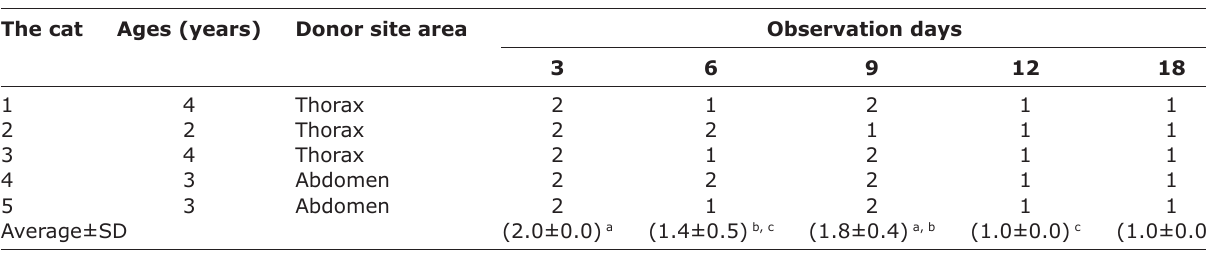
Table-2: Observation of subjective pain response test. The cat